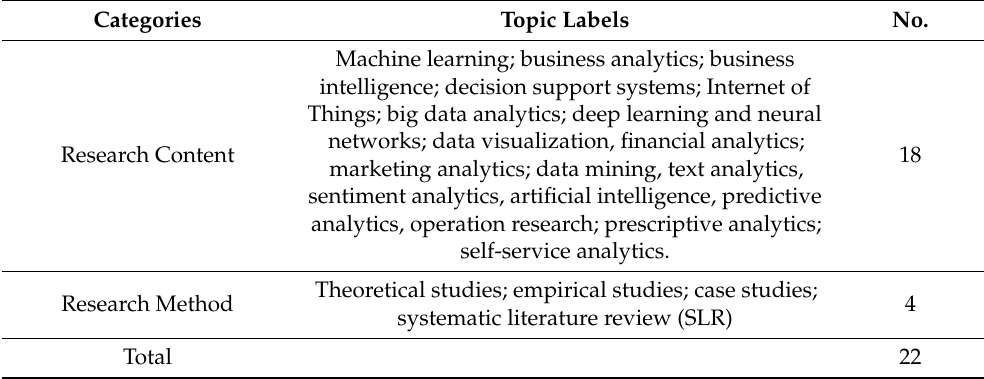
Table 5. Topic labels of the